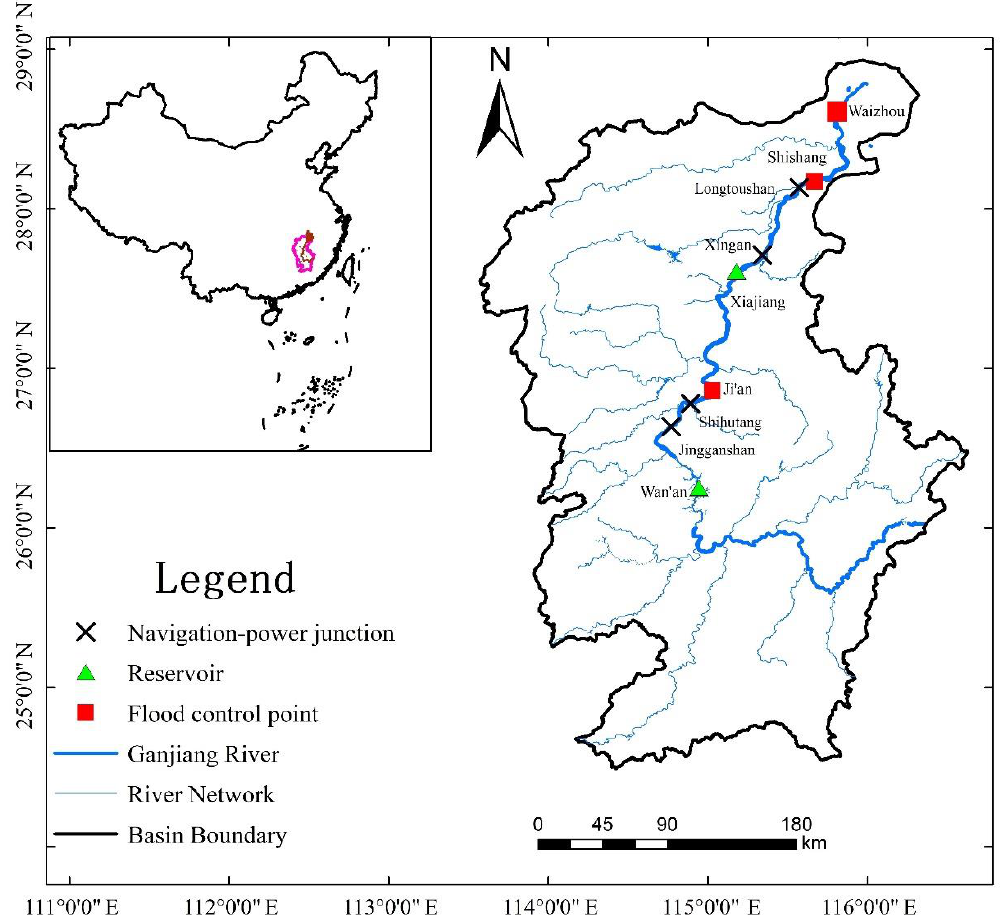
Figure 3. The location of reservoirs, navigation-power junctions, and flood control points in the Ganjiang River.